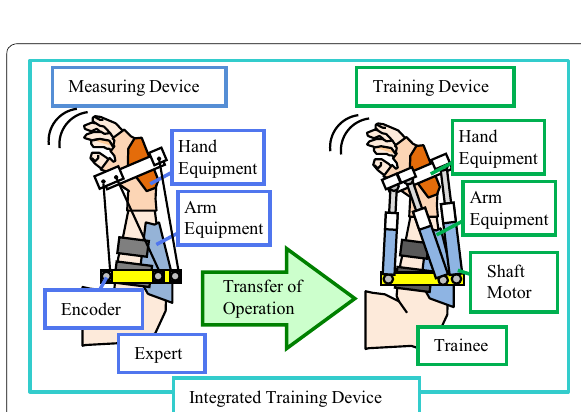
Fig. 2 Relation of the training